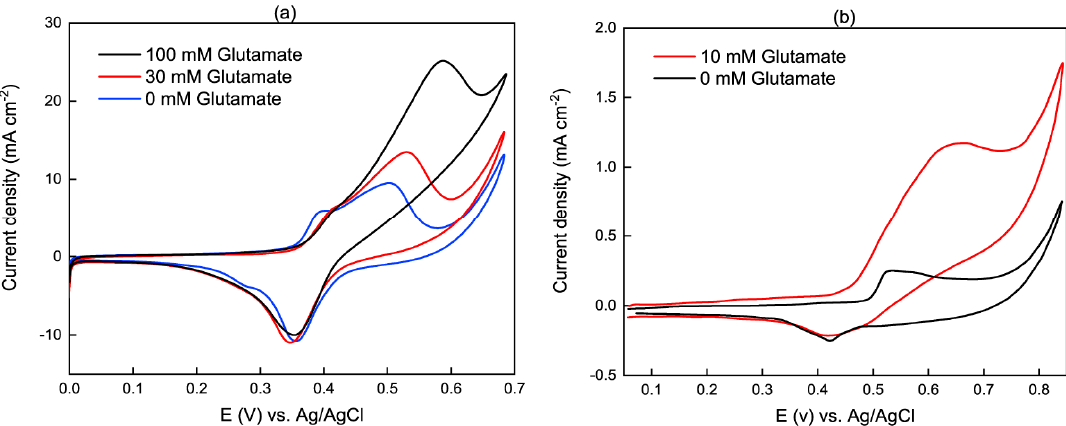
Figure 2. Example cyclic voltammetry of non-enzymatic glutamate sensors. ( a ) NiNAE electrode in 1 M NaOH with a scan rate of 0.04 V/s; ( b ) NiO/GCE electrode in 0.1 M NaOH with the scan rate of 0.05 V/s. Reproduced with permission from [28] and [31] copyright [2013], [2018], Elsevier and